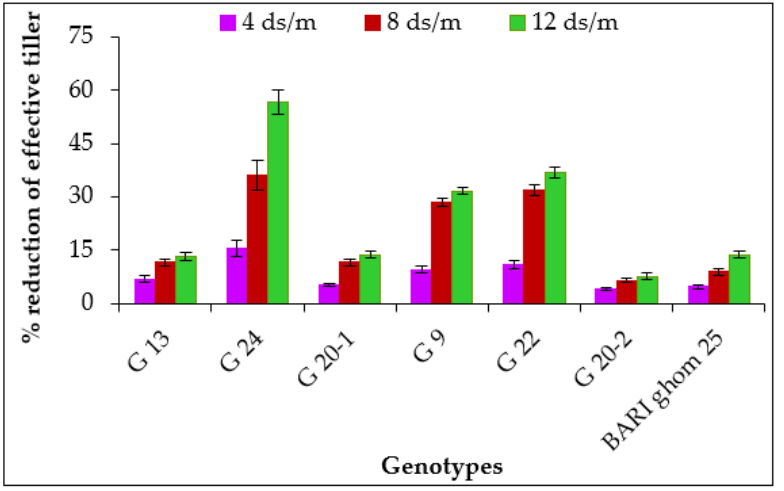
Figure 3. Reduction (%) of effective tillers of wheat genotypes under various salinity levels. The vertical bar indicates average of five independent replicates ( n = 5). Error bars represent standard error.